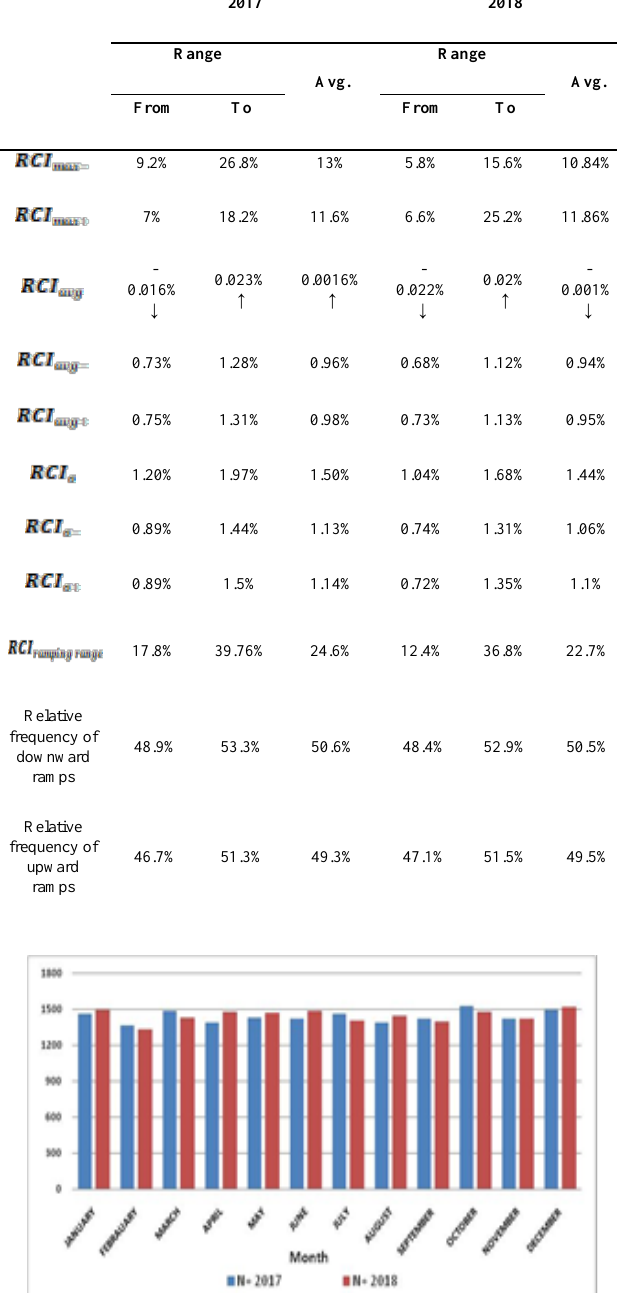
Figure 23. Comparison between numbers of upward power ramps in 15 min interval for each month for the years 2017 and